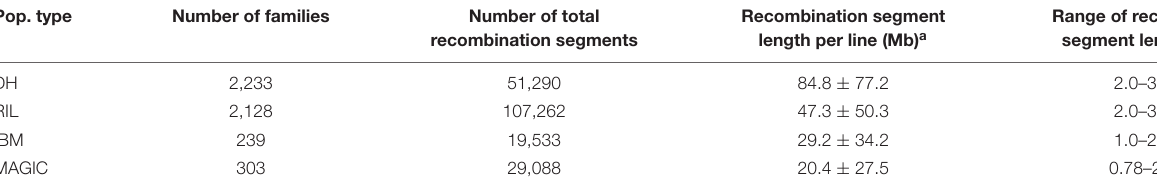
TABLE 2 | Summary of recombination segments in four types of population.